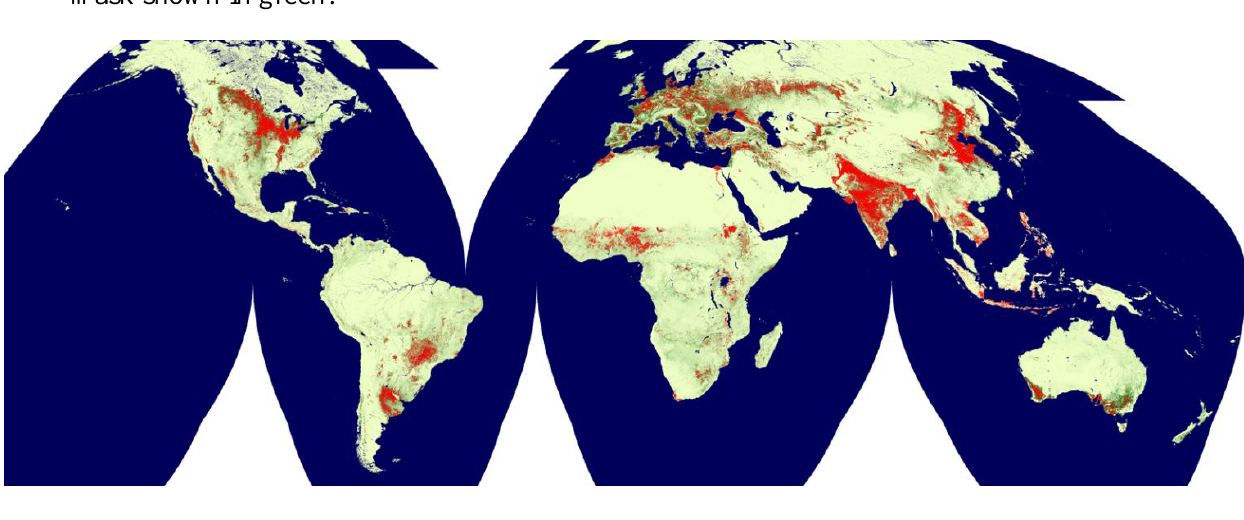
Figure 3. Global MODIS 250 m cropland product based on per country matching thresholds. Final cropland extent is shown in red, with probability values outside of final mask shown in green.